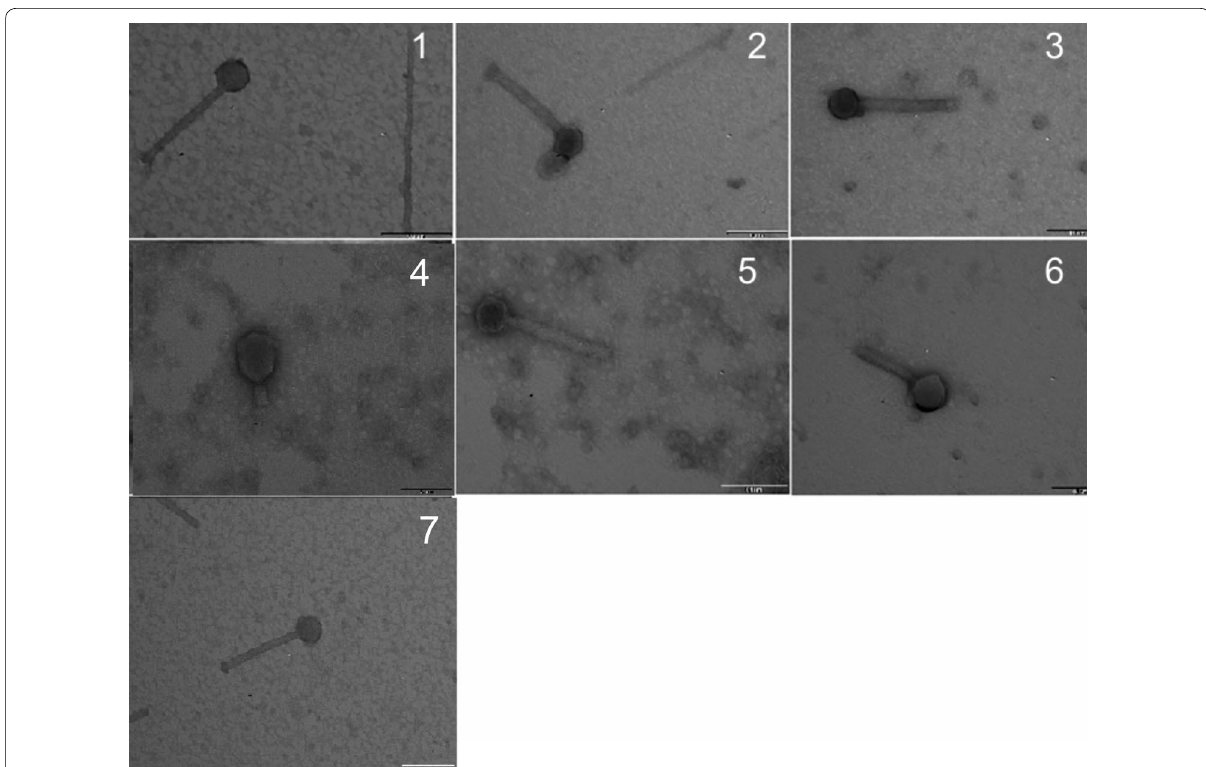
Fig. 1 Negative‑stained electron micrographs of phages induced in isolates of M. haemolytica Myoviridae ‑type phage. 1—phage induced from M. haemolytica BAA‑410; 2‑φ A1, 2—φ A2; 3—φ A3; 4—φ A5; 5—φ A6; 6—φ A7; 7—φ 25